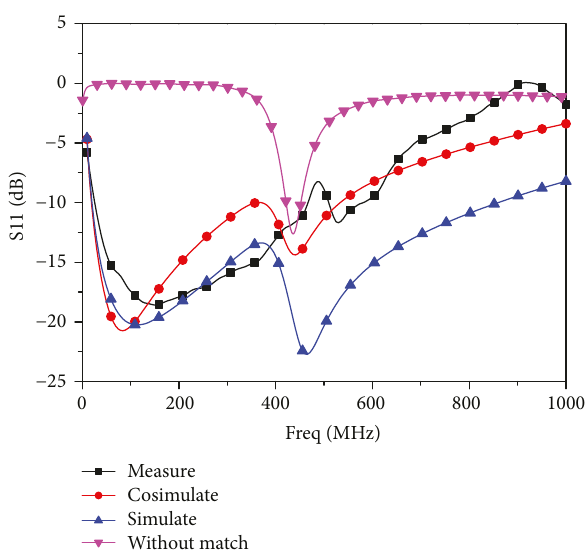
Figure 10: Re fl ection coe ffi cient of measured, simulated NIC-loaded dipole and unmatched